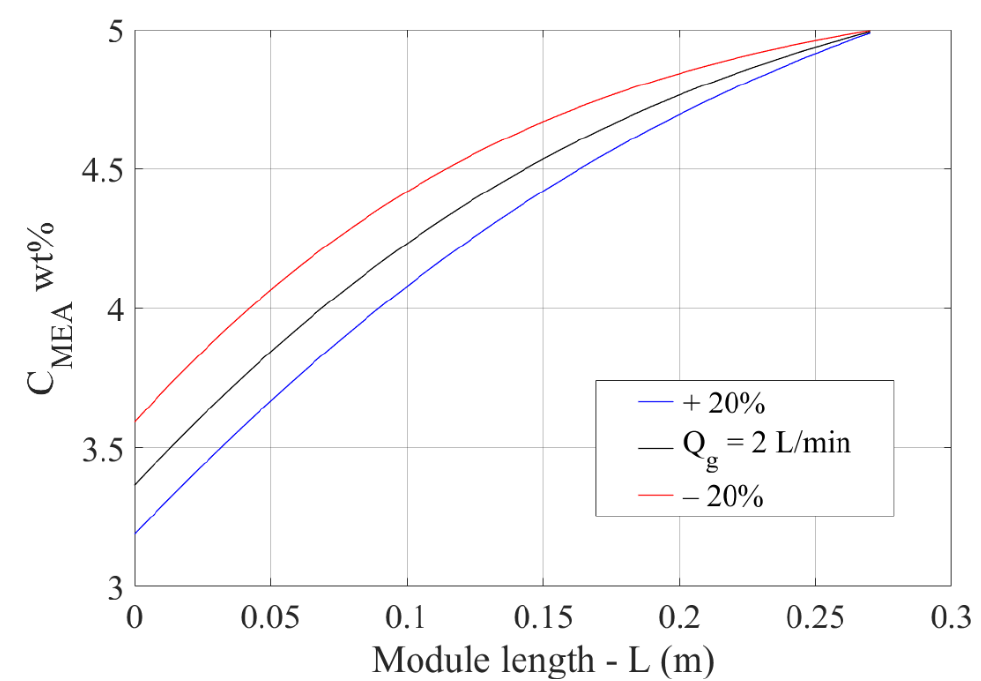
Figure 15. MEA concentration in liquid phase over the module length. Initial and new steady-state profiles (increase/decrease scenarios of gas flow rate). profiles (increase/decrease scenarios of gas flow